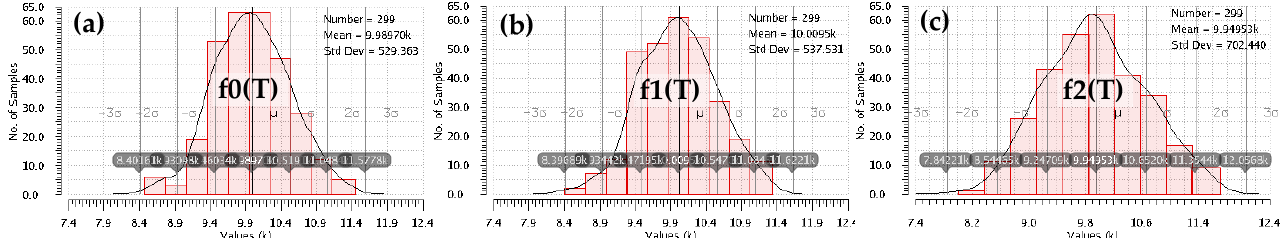
Figure 16. The spread of oscillating frequency caused by component mismatch, considering the three cases for generating the supply voltage for the sensor ring oscillator shown in Figure 15: ( a ) an ideal voltage source, ( b ) the LDO proposed here, shown in Figure 3, and ( c ) the LDO reported in [10]. Results yielded by 300 Monte Carlo simulation runs at +25 °C.